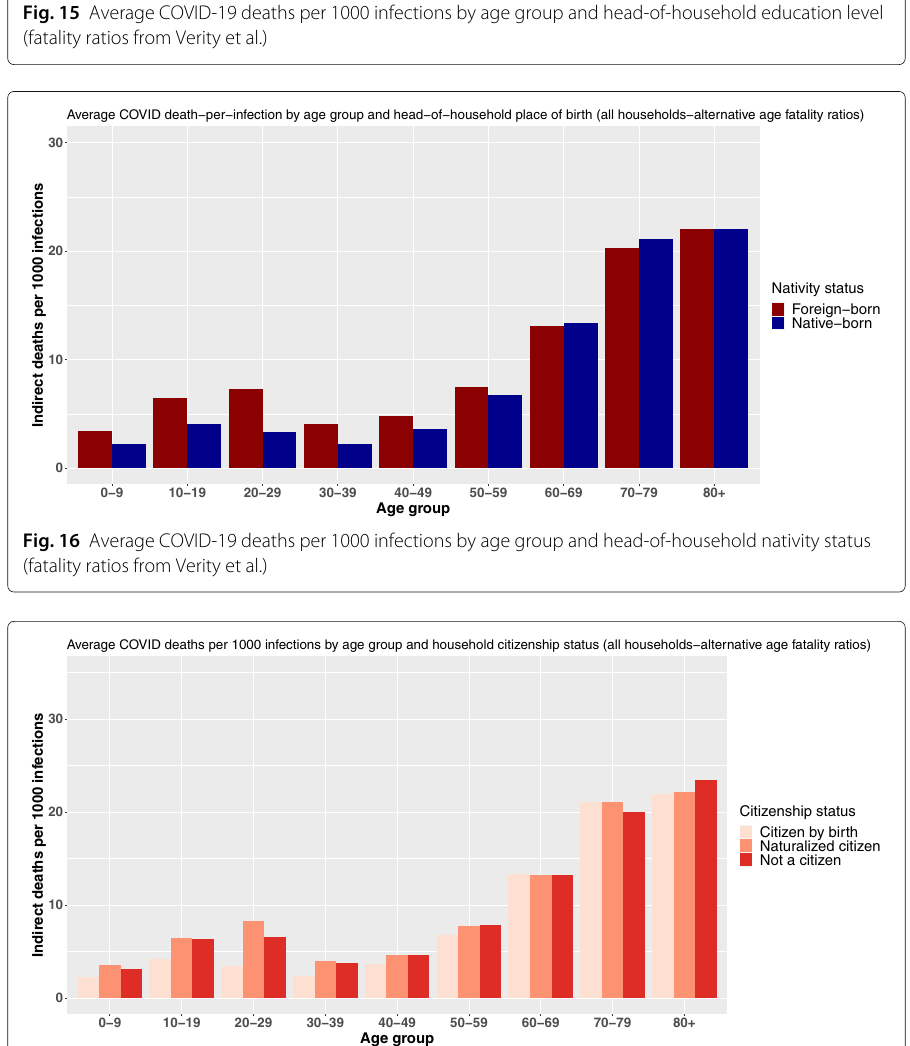
Fig. 17 Average COVID-19 deaths per 1000 infections by age group and head-of-household citizenship status (fatality ratios from Verity et